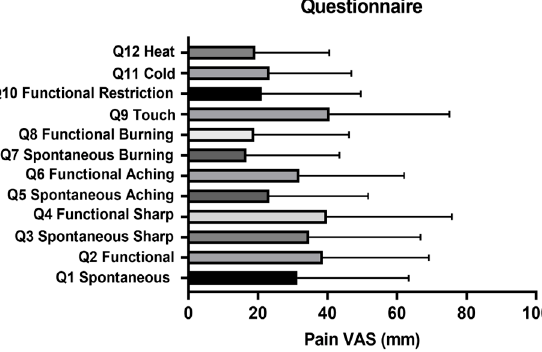
Figure 3. ( a ) VAS scores for spontaneous (Q1) pain vs. functional pain (Q2). ( b ) VAS scores for spon- taneous (Q1) pain vs. functional pain (+/-) EtOH consumption. ( c ) VAS scores for overall pain (Q1 and Q2 combined) (+/-) Nodal disease or EtOH consumption. ( d ) VAS scores for overall pain (+/-) EtOH consumption and nodal disease. * p < 0.05, ** p < 0.01, and ***p<0.001. The overall pain scores (de fi ned as total of spontaneous pain (Q1) and pain on func- tion (Q2) combined) were increased in subjects with advanced stage disease (stages 3 and 4, n = 15) compared to early stage disease (stages 1 and 2, n = 12) based on the TNM clas- si fi cation; however, none were statistically signi fi cant. When strati fi ed by the presence of nodal disease, subjects with nodal disease (n = 11) had signi fi cantly more overall pain than node negative subjects (n = 16; Figure 3c; p < 0.001).